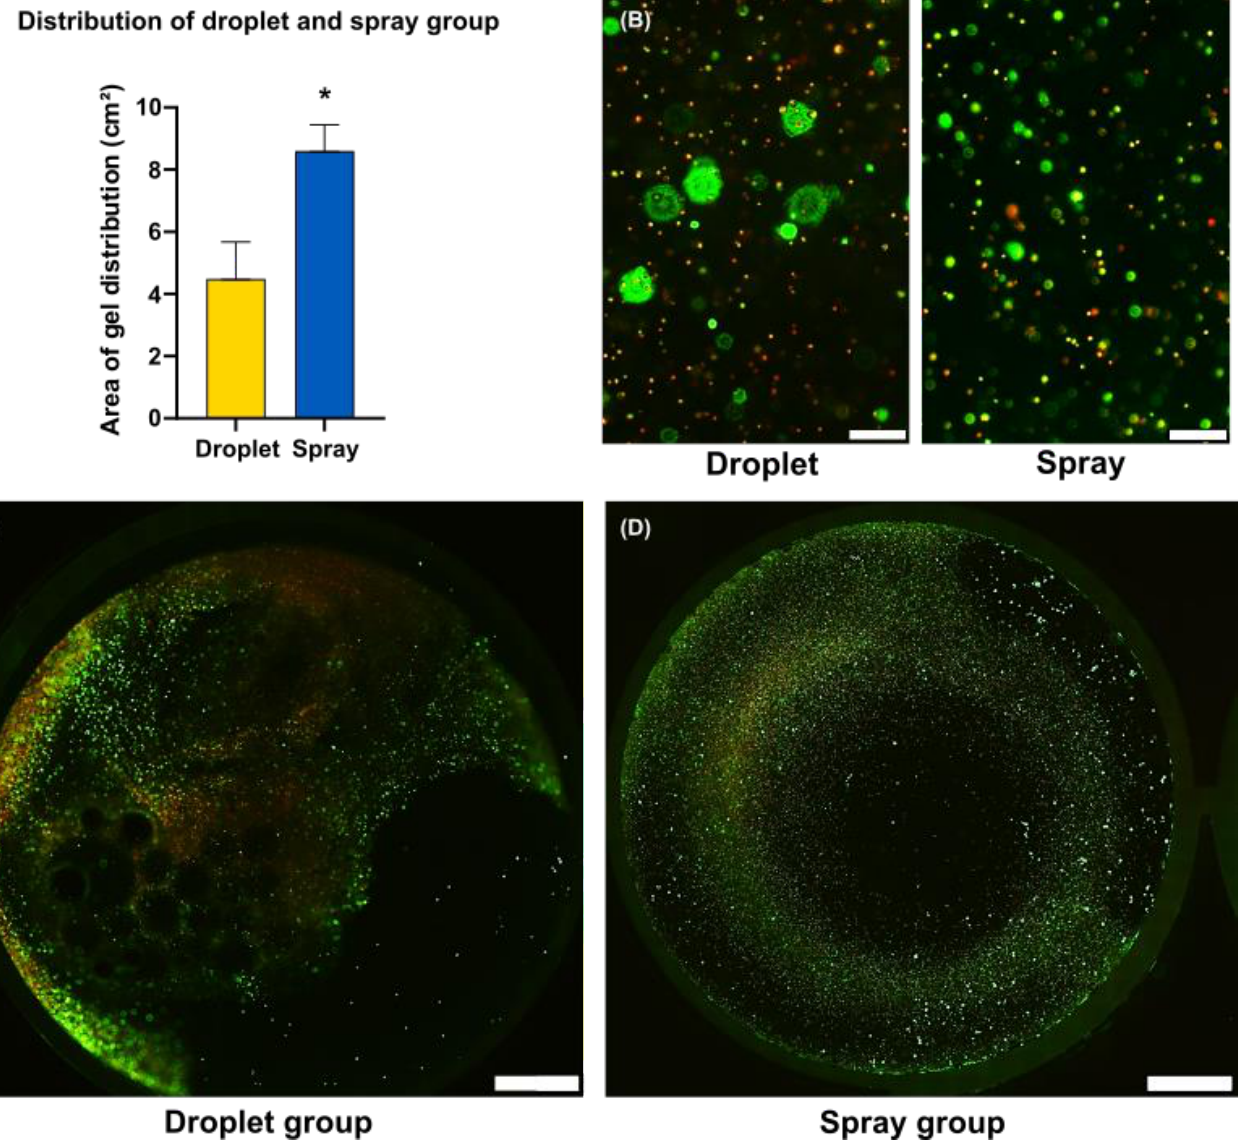
Figure 4. Distribution of keratinocytes after spray and droplet application. Sample size n = 3. ( A ) Y-axis shows surface in cm 2 on 7 d. ( B – D ) Representative images of sprayed and dripped keratinocytes at time point 8 d, live/dead staining (green = living cells, red = dead cells). Scale bar ( B ) = 200 µm, ( C , D ) 5 mm. * p ≤ 0.05, significances were correlated to the relative surface area on day 1.